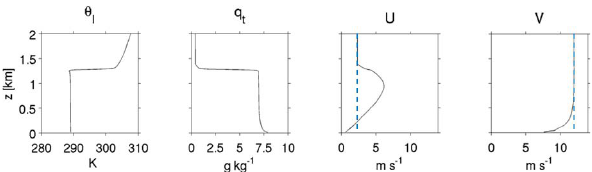
Fig. 3. Basic thermodynamic sounding and wind profiles used for all simulations. Dashed blue lines show the geostrophic wind, which is constant with height. Domain average over hours 3–4 of run W6.5/NA100